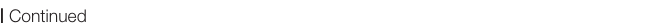
FIGURE 7 | Continued represent single spines, magenta line indicates median; p value determined using Mann–Whitney test. (H) Apparent area covered by single spines of PCs treated with CK-666 or vehicle and transfected as in (A) . Data points represents single spines, magenta line indicates median; p value determined using Mann–Whitney test. (I) Spine area changes over time of PCs treated with CK-666 or vehicle and transfected as in (A) . Data points represent SD of the relative area change of single spines monitored over 150 s, magenta line indicates median; p value determined using Mann–Whitney test. (J) Change of GFP-actin fluorescence intensity over time in spines of PCs treated with CK-666 or vehicle and transfected as in (A) . Data points represent the SD of the relative fluorescence change of single spines monitored over 150 s, magenta line indicates median; p value determined using Mann–Whitney test. (K) Circularity index of spines of PCs transfected as in (A) and treated with SMIFH2 (blue; final concentration, 40 µ M) or with vehicle (0.2% [v/v] DMSO; black). Data points represent single spines, magenta line indicates median; p value determined using Mann–Whitney test. (L) Apparent area covered by single spines of PCs treated with SMIFH2 or vehicle and transfected as in (A) . Data points represent single spines, magenta line indicates median; p value determined using Mann–Whitney test. (M) Spine area changes over time of PCs treated with SMIFH2 or vehicle and transfected as in (A) . Data points represent SD of the relative area change of single spines monitored over 150 s, magenta line indicates median; p value determined using Mann–Whitney test. (N) Change of GFP-actin fluorescence intensity over time in spines of PCs treated with SMIFH2 or vehicle and transfected as in (A) . Data point represent SD of the relative fluorescence change of single spines monitored over 150 s, magenta line indicates median; p value determined using Mann–Whitney test. (O) Examples of spines of PCs treated with SMIFH2 or vehicle and transfected as described in (A) . GFP-actin was visualized